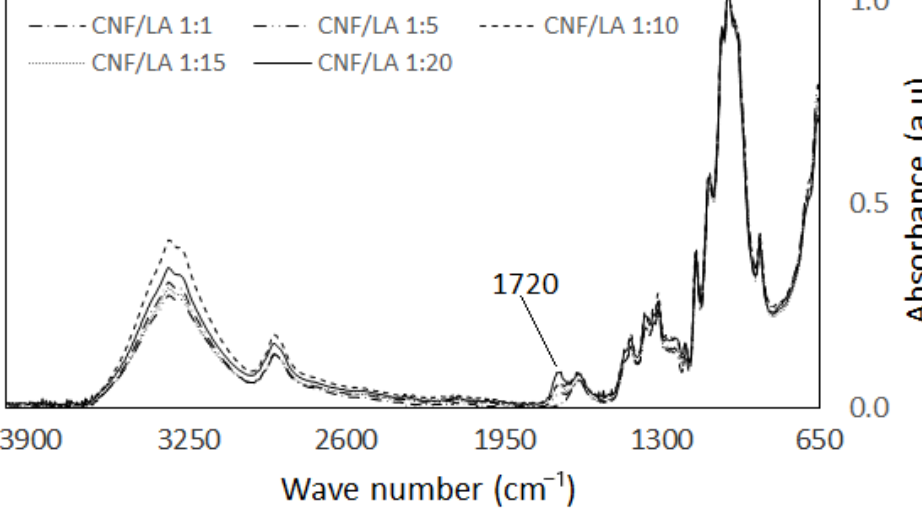
Figure 4. FTIR spectra showing the effect of the ratio of CNF:LA on the modification of